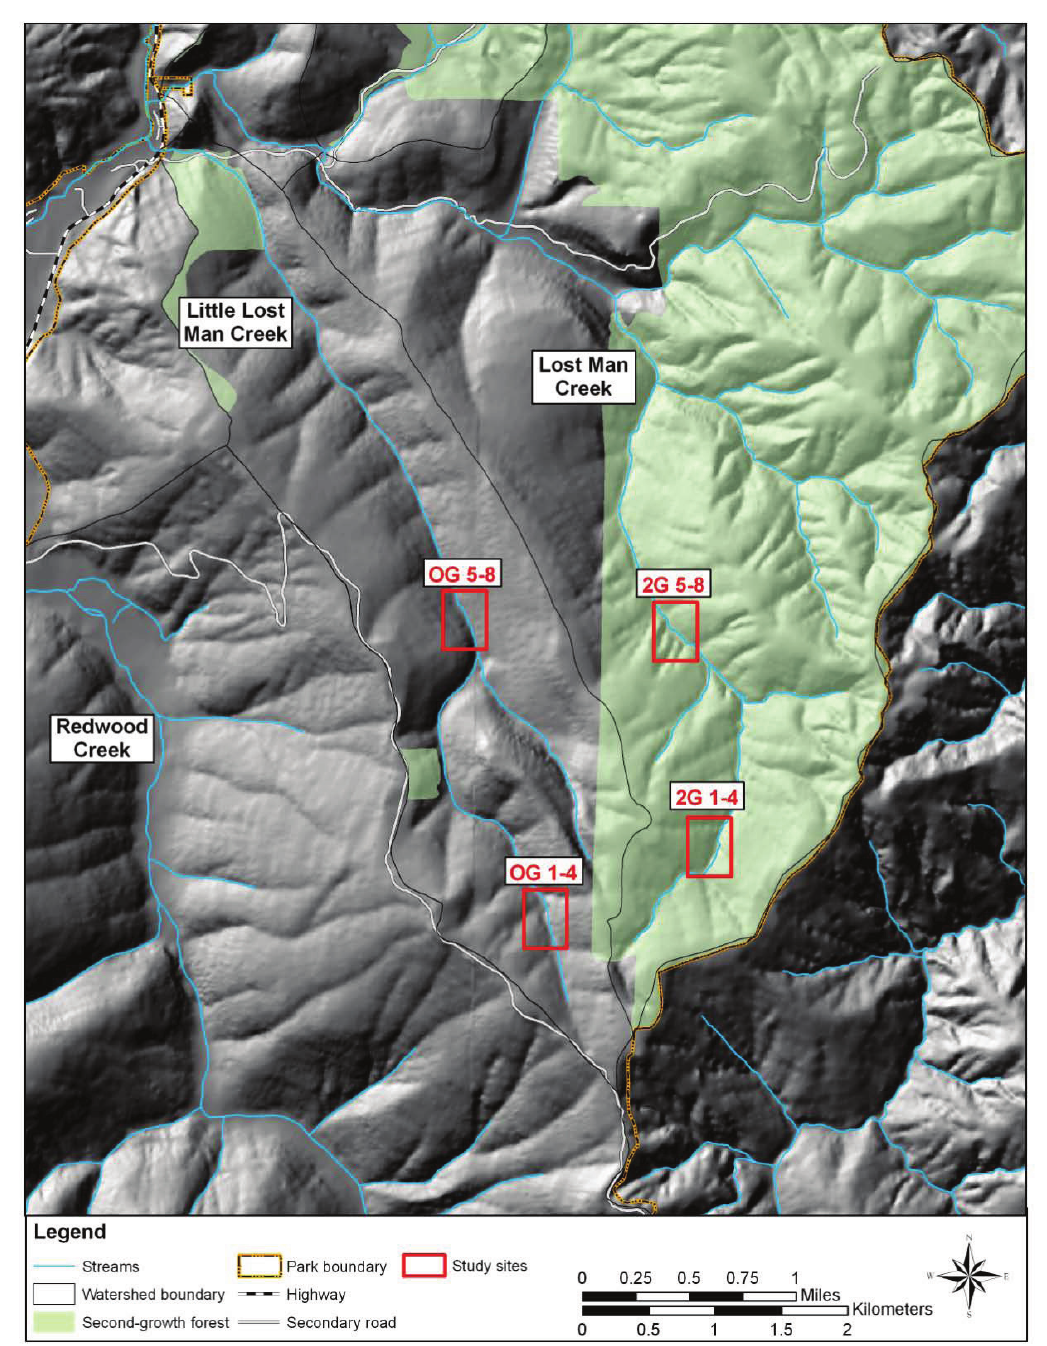
Figure 1. Study location at Redwood National Park, USA (Little Lost Man and Lost Man Creeks). Plot numbers are indicated as OG (old-growth) 1–8 and 2G (second-growth)